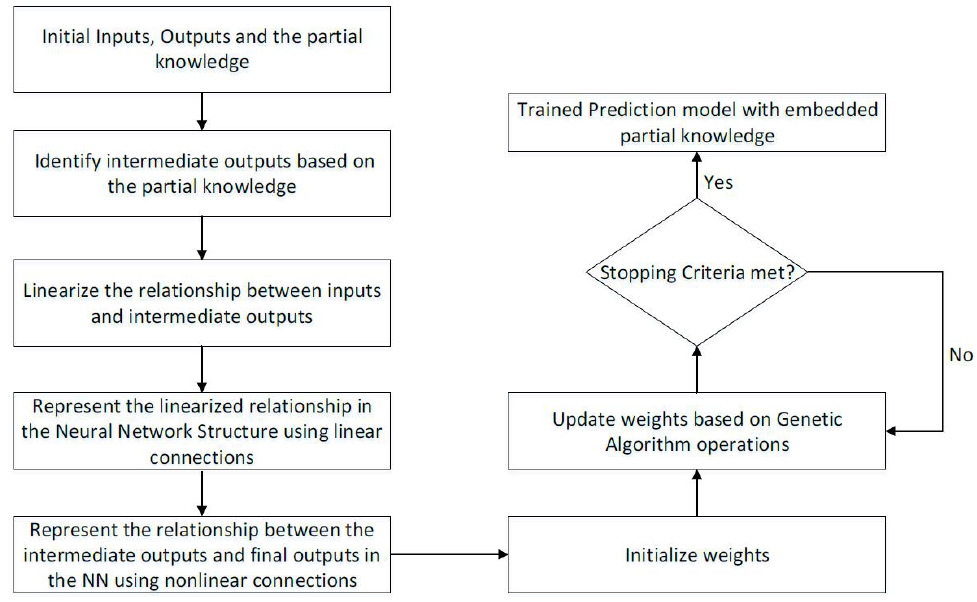
Figure 3. Flowchart of the proposed idea.